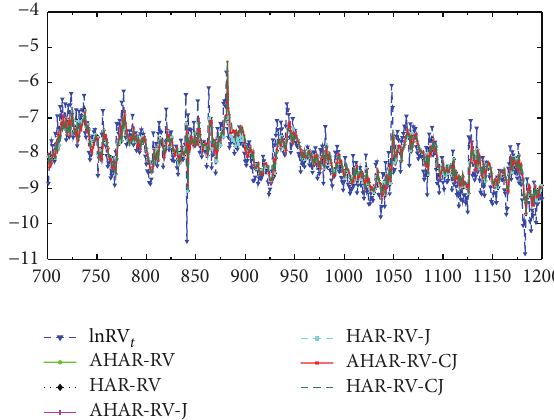
Figure 3: Out-of-sample forecasts for the CSI 300 index’s volatility in five successive forecast windows. lnRV 𝑡 represents the true logarithmic realized volatility. AHAR-RV, HAR-RV, AHAR-RV-J, HAR-RV-J, AHAR-RV-CJ, and HAR-RV-CJ represent the forecasts of the corresponding models,